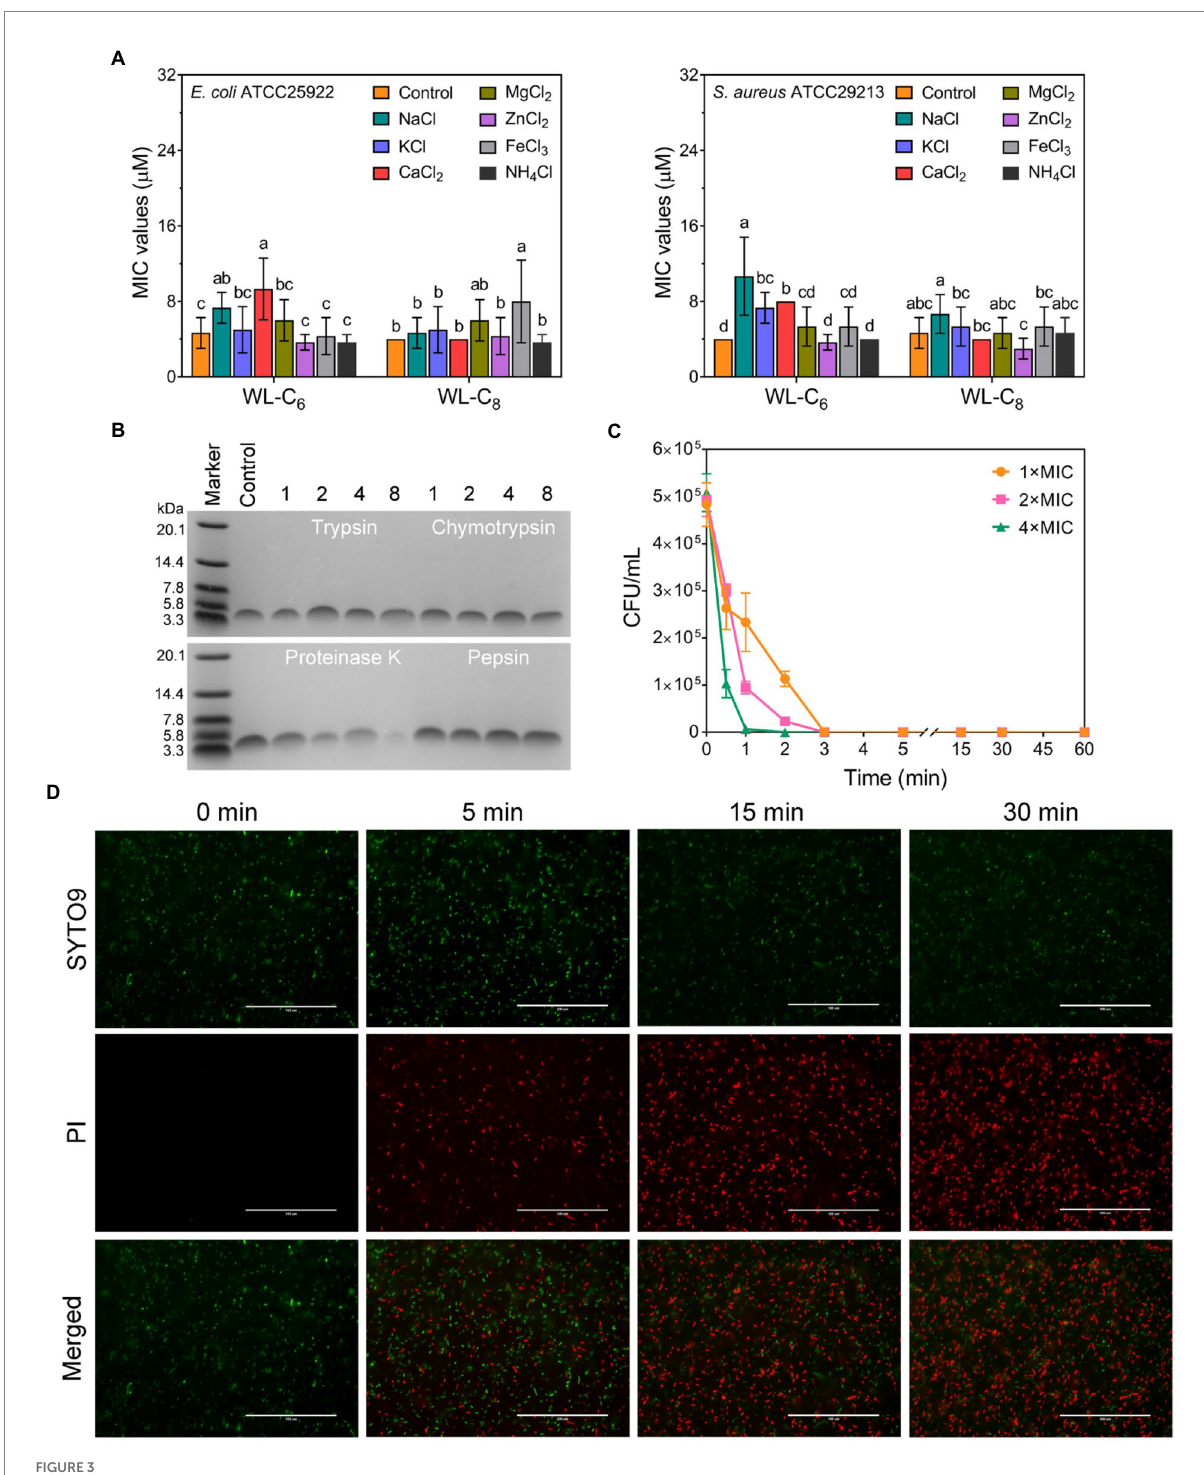
FIGURE 3 (A) Salt sensitivity of the lipidated peptides. To evaluate the peptide salt stability, the MICs of the lipidated peptides at physiological salt concentrations were employed. Data: mean ± SD ( n = 6). The values with different superscripted letters (a–d) indicate a significant difference ( p < 0.05). (B) 16.5% tricine − SDS − PAGE analysis of the WL-C 6 after treatment with 500 μ g/ml of chymotrypsin, trypsin, pepsin, or proteinase K for 1, 2, 4, and 8 h at 37 ° C. Control: untreated WL-C 6 . (C) Bactericidal kinetics of WL-C 6 against Escherichia coli ATCC25922 at concentrations of 1 ×, 2 × and 4 × MIC. Data: mean ± SD ( n = 3). (D) Fluorescence images of E. coli cells at points of time of 0-, 5-, 15-, and 30-min following treatment with 1 × MIC WL-C 6 and stained with SYTO 9 (green) and PI (red). Scale bars, 100 μ